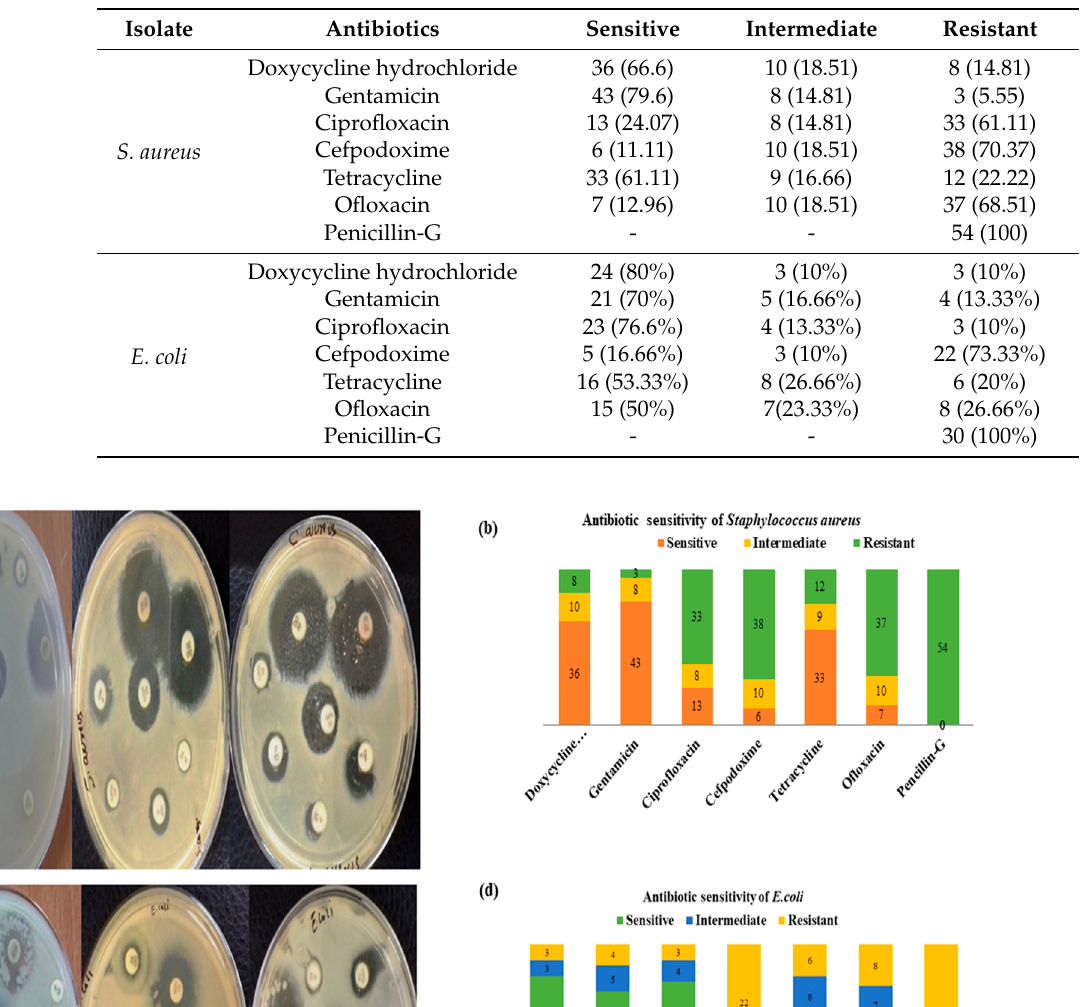
Table 7. In vitro antibiogram of S. aureus isolates ( n = 54) and E. coli ( n = 30) in comparison with various antibiotics.